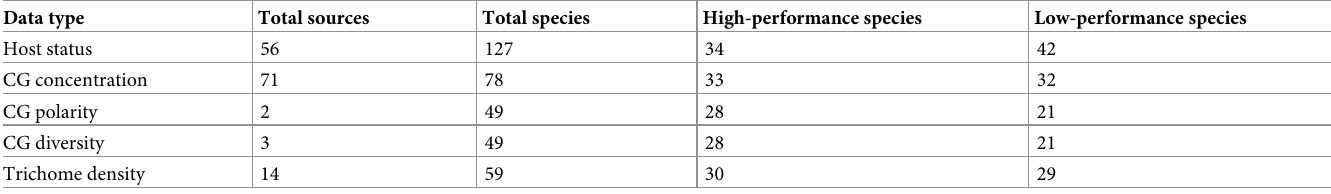
Table 2. Literature search results